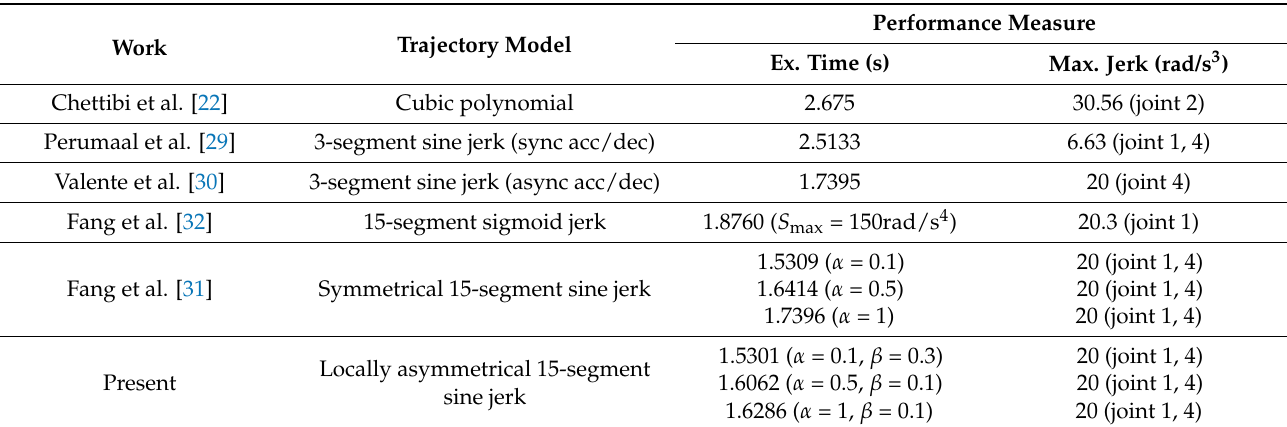
Table 2. Measured performances from various trajectory models for the test